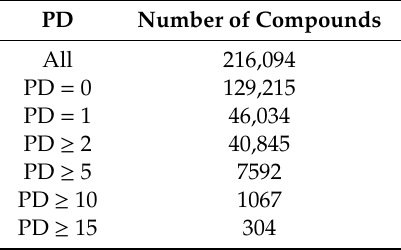
Table 1. Reported are the numbers of compounds with di ff erent promiscuity